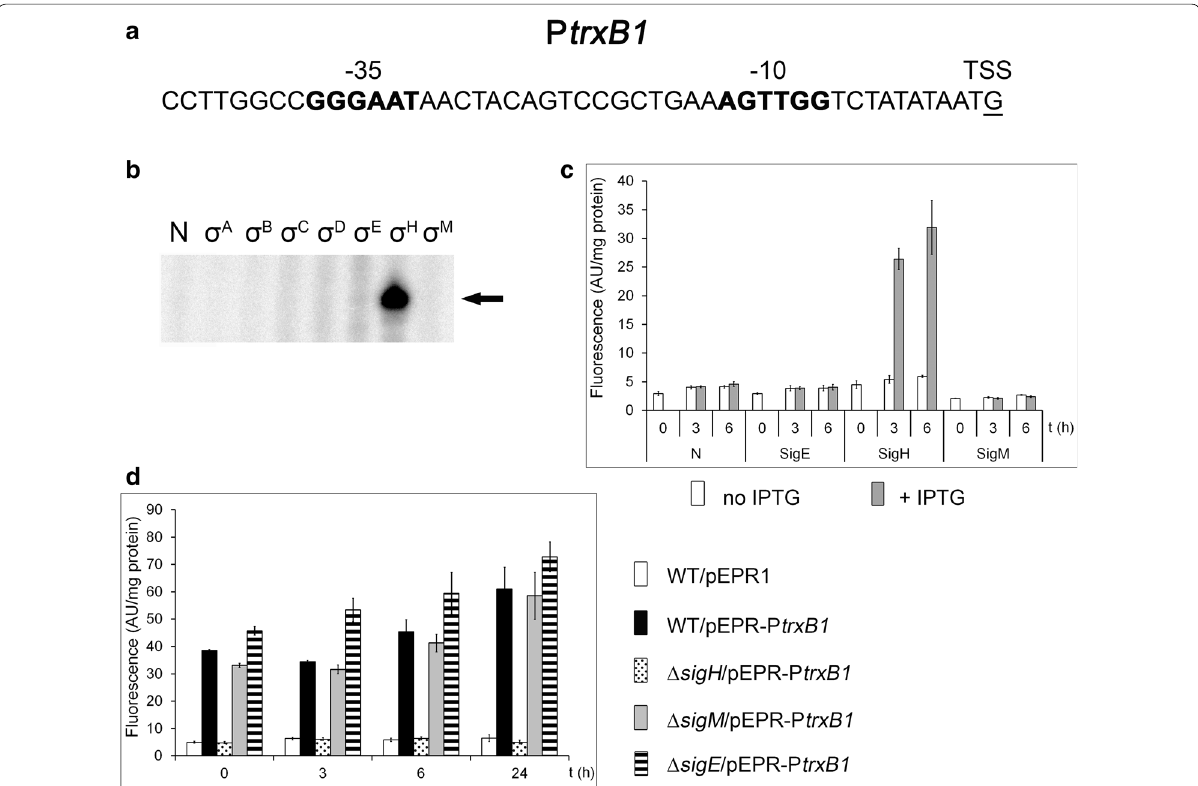
Fig. 2 Assignment of a sigma factor to the P trxB1 promoter. a Sequence of the P trxB1 promoter (Nakunst et al. 2007). The elements are in bold , the transcriptional start site is underlined . b In vitro transcription with P trxB1 as a template. Individual sigma factors associated with RNAP are shown at the top . N no sigma factor was added to the RNAP core. The specific transcript is indicated with an arrow . c P trxB1 activity determined with the two-plasmid system in C. glutamicum ∆ sigH by measuring the fluorescence intensity of the Gfpuv reporter. The sigma factors whose genes were overexpressed are indicated at the bottom . IPTG was added at time 0. d P trxB1 activity in C. glutamicum ∆ sigH , ∆ sigM or ∆ sigE strains carrying a single plasmid, pEPR-P trxB1 . The values for the WT strain carrying the empty vector pEPR1 are shown as a control. AU arbitrary units. The SDs of three measurements are depicted as error